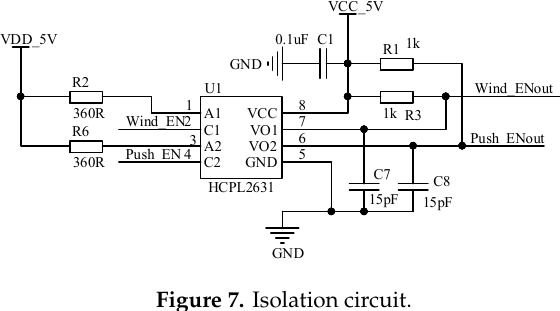
Figure 7. Isolation circuit.